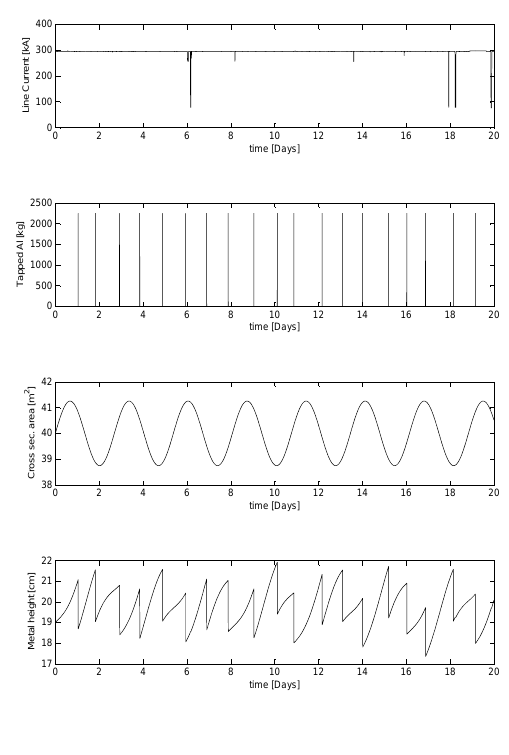
Figure 3: Simulations of the three input variables (Line current, Tapped Aluminium, and The hori- zontal Cross sectional area of the metal pad) and the output variable (Metal height) con- sidered in the simplified model of an alu- minium electrolysis